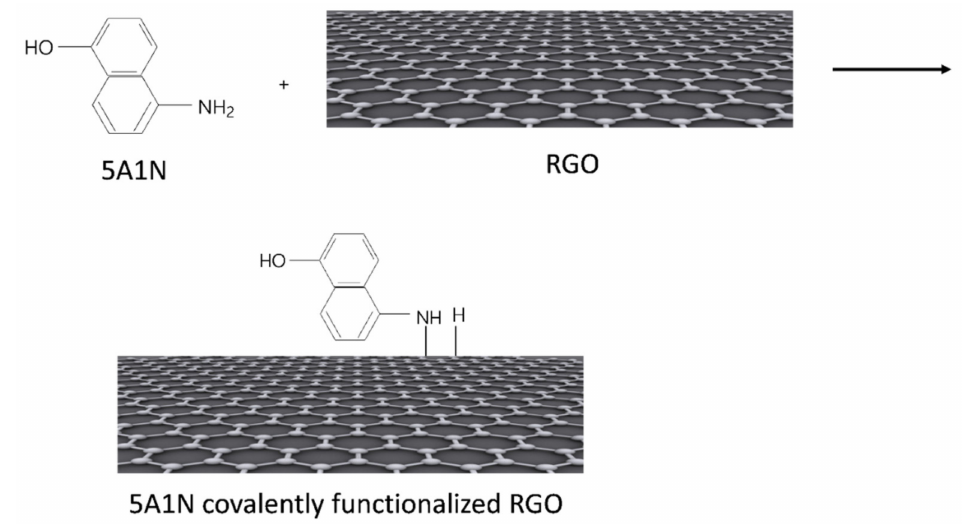
Scheme 1. The chemical interaction of 5A1N with the RGO